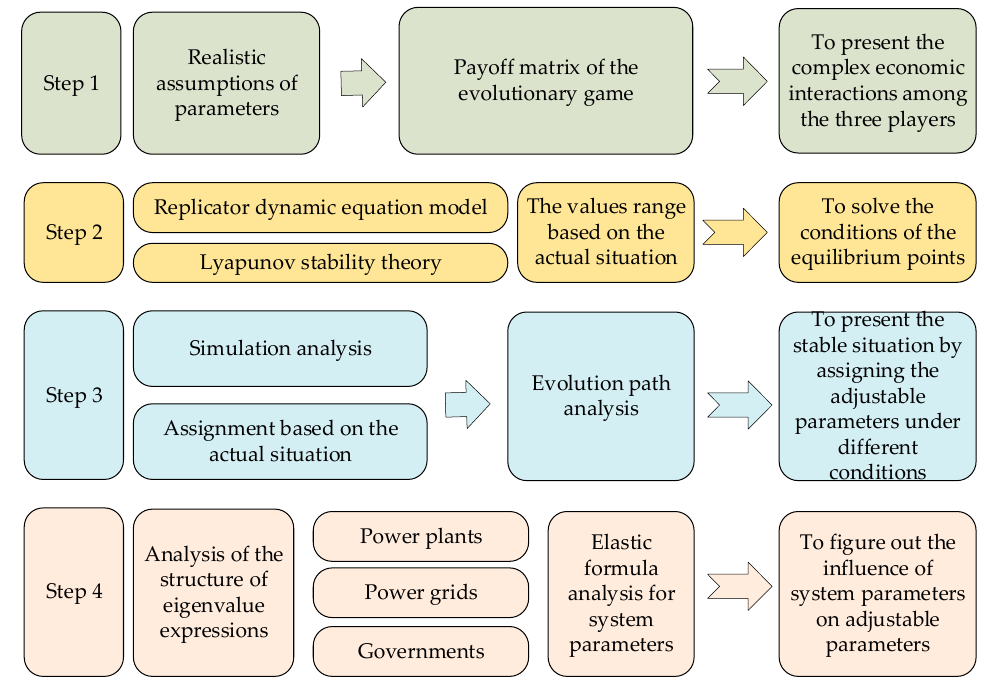
Figure 1. The framework of evolutionary game analysis.